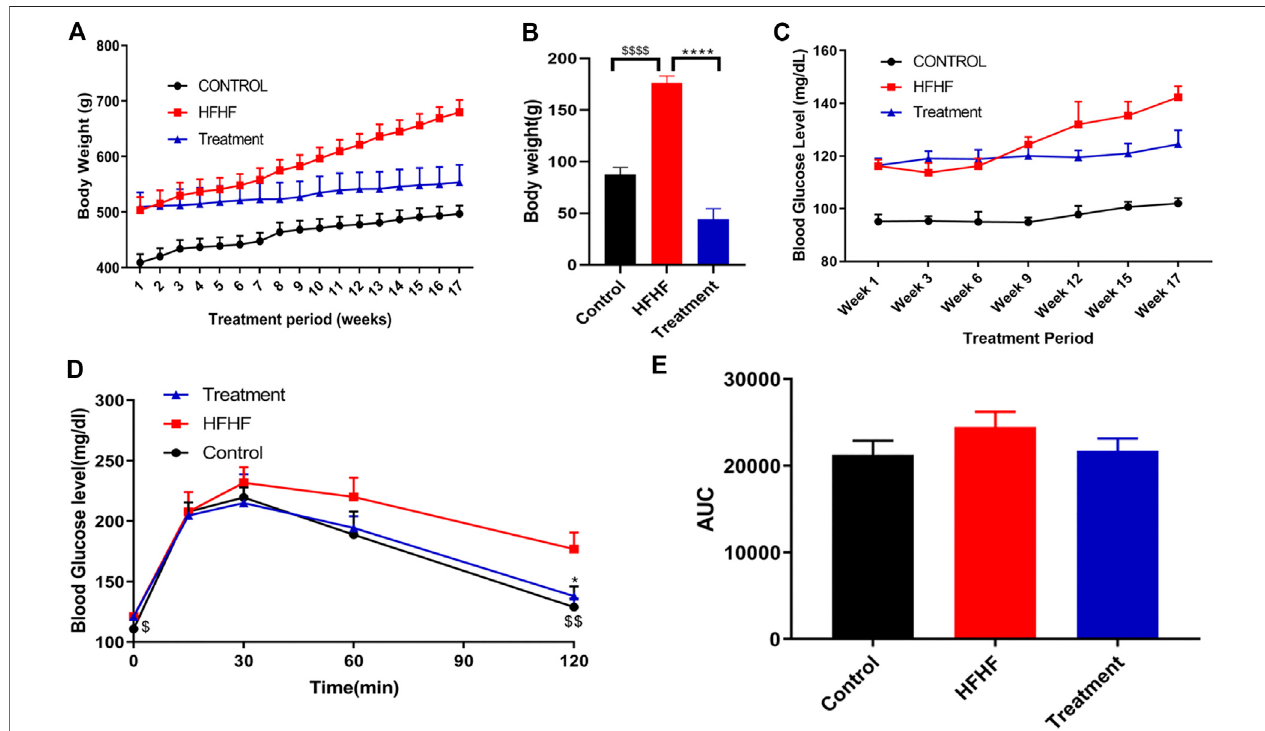
FIGURE 1 | Effect of Lysimachia candida Lindl. extract administration on the physical parameters of rats (A) Body weight, (B) Body weight change, (C) Fasting bloodglucose, (D) IPGTT, (E) AUCofglucoselevel.Dataareexpressedasmean ± SD( n (cid:2) 6)eachgroup, p < 0.0001****signi fi esthestatisticaldifferencebetweenHFHF andTreatment, p < 0.05*signi fi esthestatisticaldifferencebetweenHFHFandTreatment, p < 0.0001$$$$signi fi esthestatisticaldifferencebetweenHFHFandControl, p < 0.005 $$ signi fi es the statistical difference between HFHF and Control, p < 0.05 $ signi fi es the statistical difference between HFHF and Control.